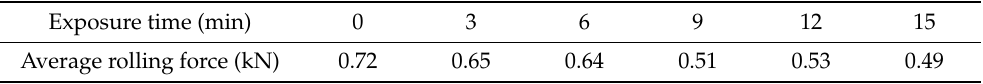
Table 4. The average rolling force at different microwave exposure